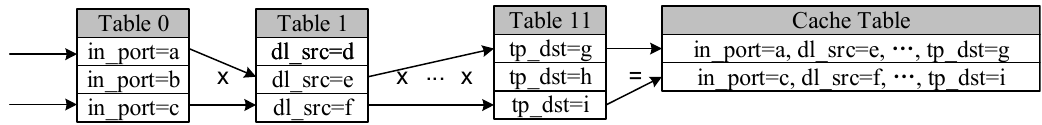
Figure 2. An example of creating big rules in the caching table. The match fields and the actions of caching table entries are the combinations of the matched rules in the OpenFlow pipeline.